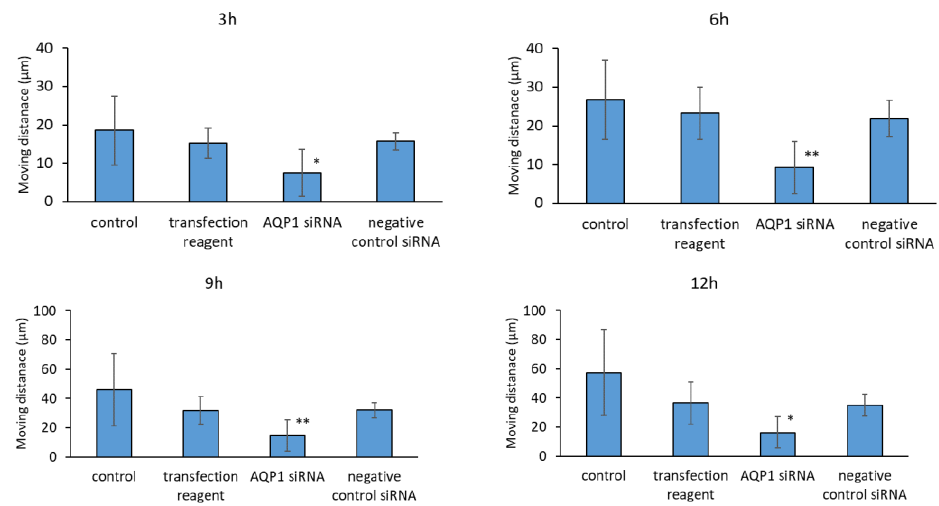
Figure 2. Motility activity of human dermal fibroblasts cultured with the addition of AQP1 siRNA. *: p < 0.05 vs. the transfection reagent. **: p < 0.01 vs. the transfection reagent. The figures show the means ± standard deviations ( n = 7).